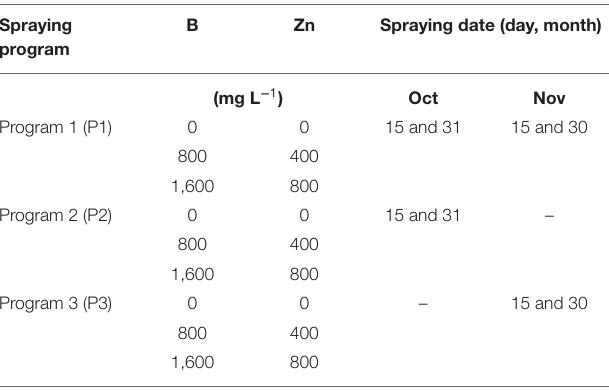
TABLE 2 | Experimental arrangement of spraying program, B and Zn concentrations (mg L − 1 ) and time during season 2016/17 (austral hemisphere)